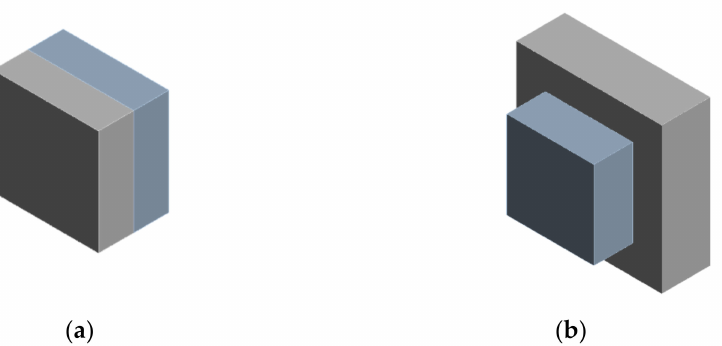
Figure 1. Potential piezoelectric actuators: ( a ) plates of the same dimensions/different materials and ( b ) plates of the same material/different